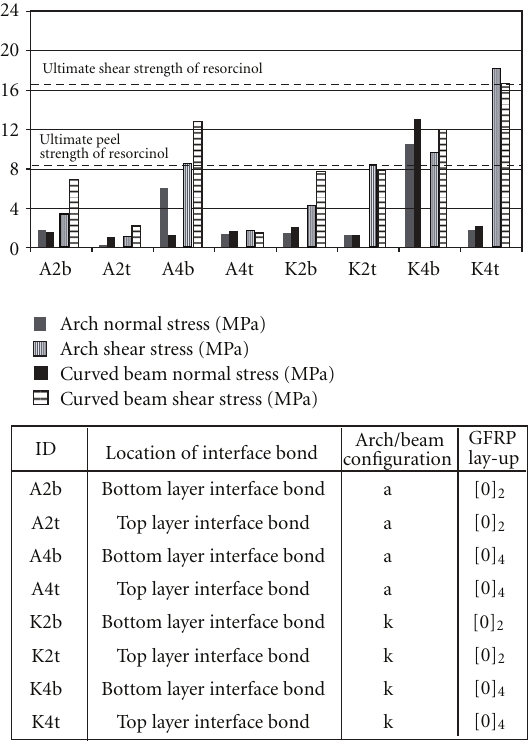
Figure 4: Maximum values of the peel and shear stresses within the adhesive along various interface bond lines obtained by FE analyses.